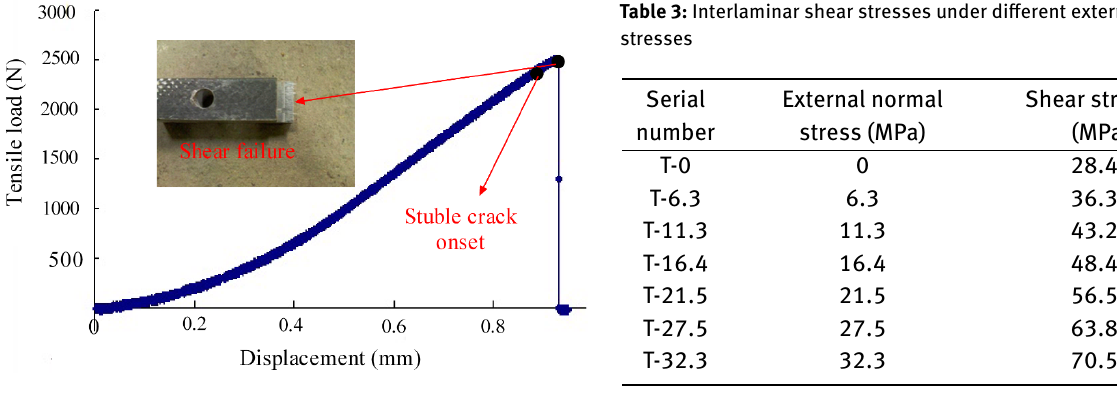
Figure 7: Load-displacement curve without external normal stress